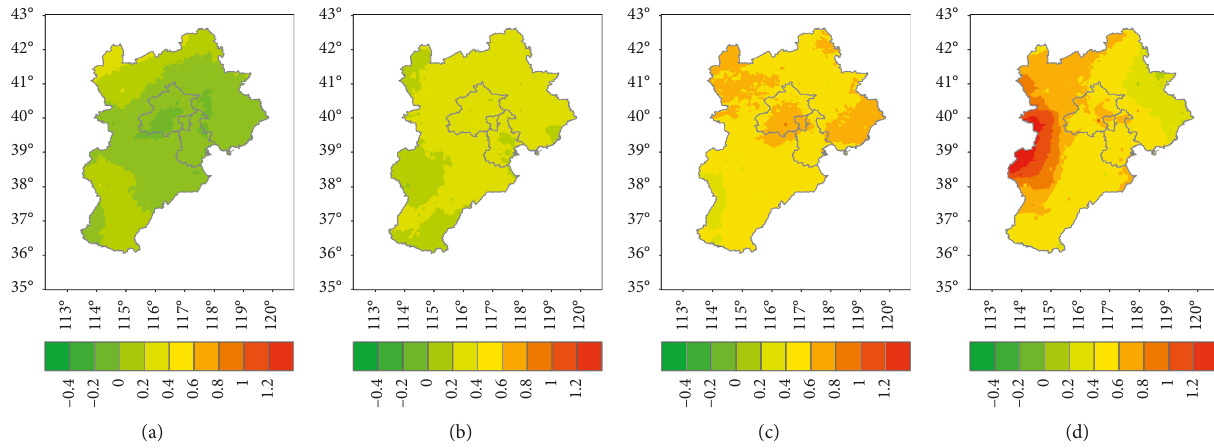
Figure 9: Interdecadal variations in mean temperature for the entire year over the Beijing-Tianjin-Hebei region: (a) T2-T1; (b) T3-T2; (c) T4-T3; (d)